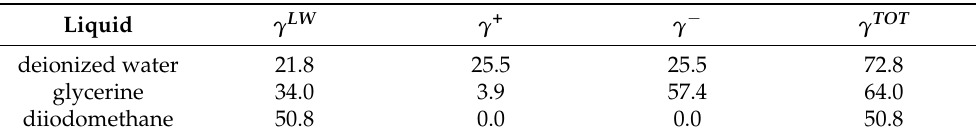
Table 4. Surface tension parameters of the three test liquids.